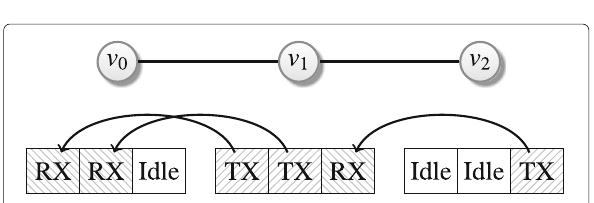
Fig. 2 An exemplary schedule corresponding to N = 3, l S = 3, T = () , R 0 K ( 0 ) = 0, K 1